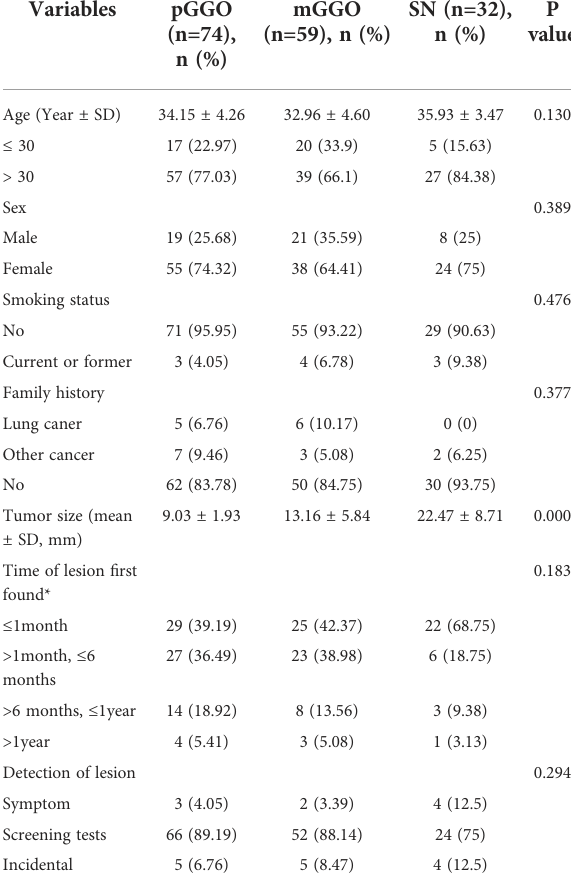
TABLE 1 Clinical features of Patient.